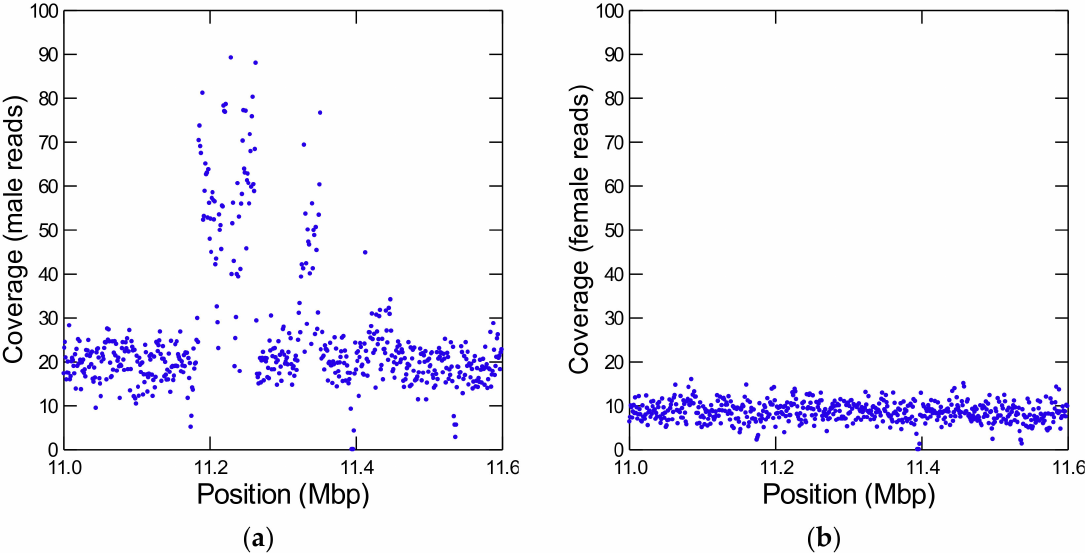
Figure 2. Detection of a Y-linked segmental duplication from an autosome. The figure shows the coverage of Illumina reads from males ( a ) and females ( b ) in a part of the autosomal scaffold CH964272. Note the huge increase in male coverage between positions ~11.2–11.4 Mbp, which is absent in the female reads. It corresponds to a segmental duplication of at least 265 kb from CH964272 to the Y chromosome. The coverage is very high and irregular, indicating many partial duplications and deletions inside the Y-chromosome. Each dot is the average depth of 1 kb interval (to reduce scattering). In the raw data, some regions have at least ten